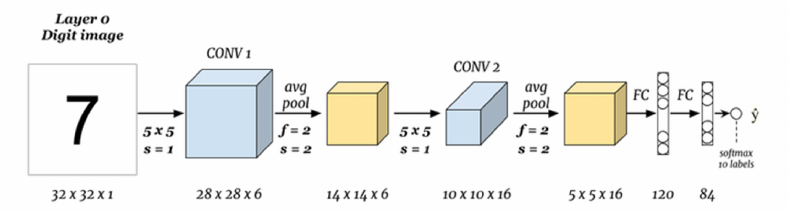
Fig. 4. LeNet-5 architecture [19]